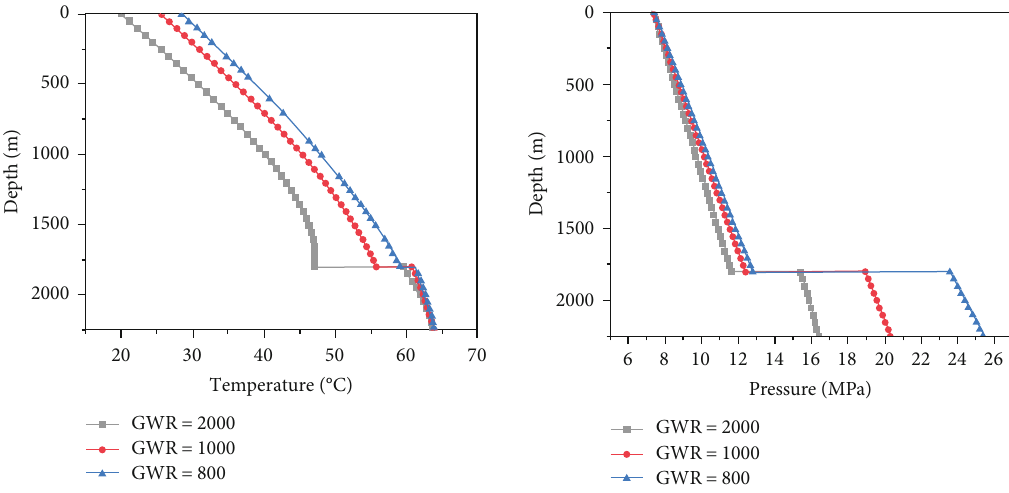
Figure 6: Choke temperature and pressure distribution of Daji 4-5 well.